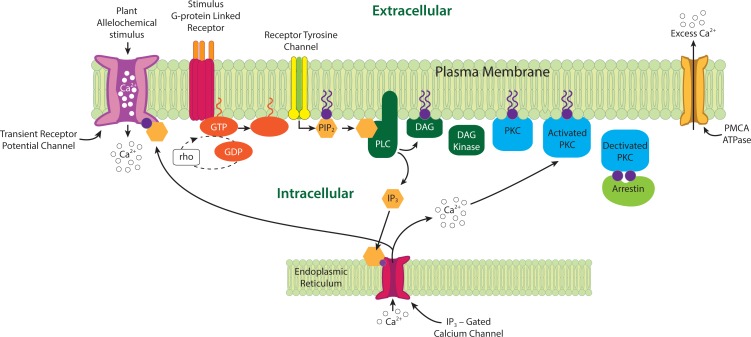
Calcium signaling in phosphoinositide metabolism.PIP2—phosphatidyl-inositol 4,5 bisphospate; PLC—phosphatidylinositol-4,5-bisphosphate phosphodiesterase-1; IP3—inositol triphosphate; DAG—diacylglycerol; PKC—protein kinase C.